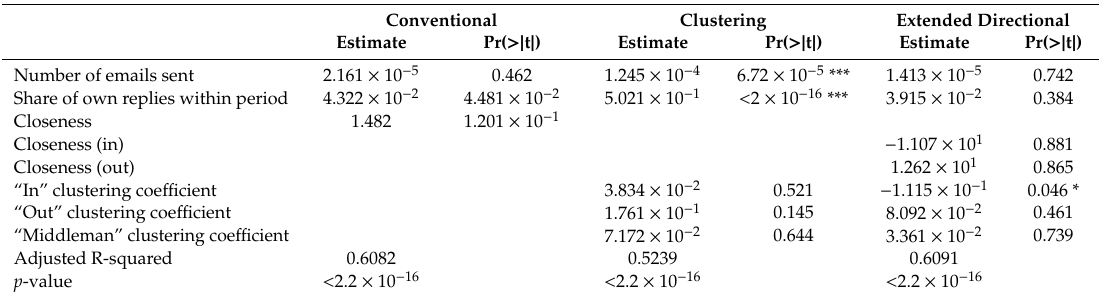
Table A3. Enron dataset, 7-day